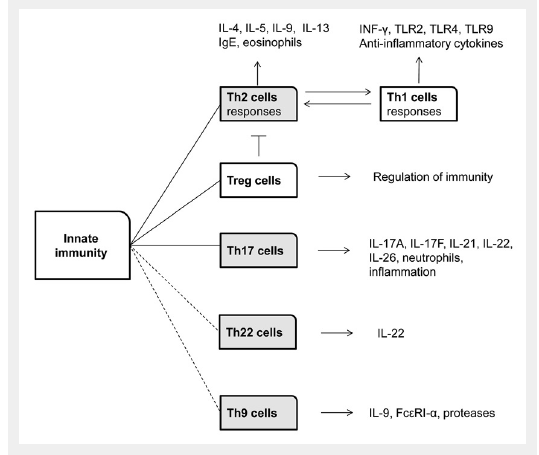
Contributions of different immune system cells and molecules in pathogenesis of childhood asthma. The solid lines describe the T helper cells that have been associated with asthma in humans whereas the broken lines represent asthma studies that have been conducted in animal models and their role in human is yet to be determined. Th2 responses lead to production of IL-4, IL-5, IL-9, IL-13 which are associated with increased levels of IgE and eosinophils leading to asthma. Th1 responses include anti- inflammatory cytokine INF-γ, and early infant immune system development (possibly by TLR-2, TLR-4, TLR-9). Th1 responses render protection against asthma. Tregs inhibit the production of Th2 cells and Th2 cytokines, and are regulators of immune system self- tolerance, prevent autoimmunity and suppress allergies. Th17 cells produce pro-inflammatory cytokines IL-17A, IL-17F, IL-21, IL-22, IL-26 and are associated with an increased number of neutrophils and amount of inflammation. Th22 cells, which produce pro- inflammatory IL-22, are believed to play an important role in asthma pathogenesis. Th9 cells produce IL-9, which stimulates expression of FcεRI-α and mast cell proteases. Th9 cells are also believed to play an important role in asthma